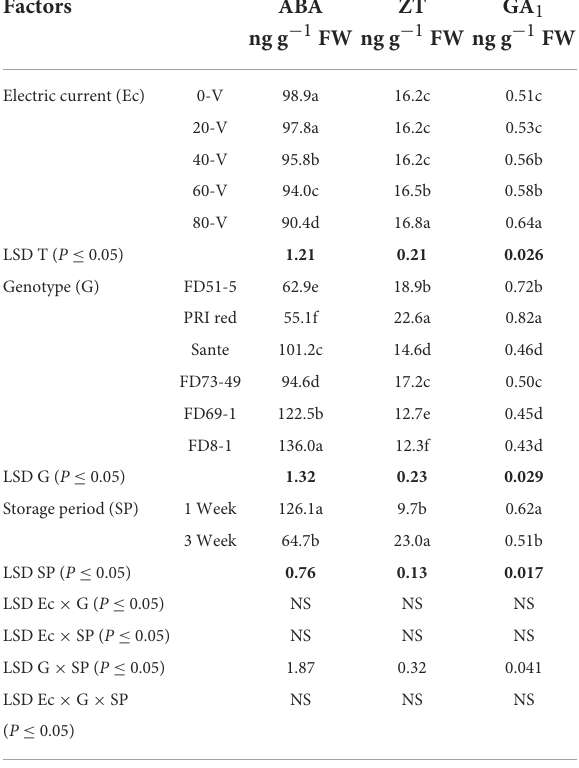
TABLE 3C Periodic changes in the contents of ABA, ZT, and GA 1 in experimental tubers of six potato genotypes following treatment